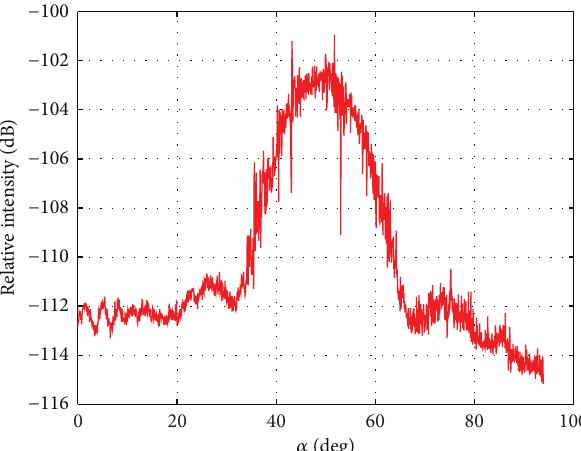
Figure 4: Strip chart of Cassiopeia A passing through the antenna array pattern due to the Earth’s rotation at 57.105 MHz. The angle 𝑡 is proportional to the travel time 𝑡 of Cassiopeia A, and the 𝛼 = V 𝛿 source velocity on the celestial sphere for the declination 𝛿 is defined as V 𝛿 = 15( 󸀠󸀠 / sec ) cos 𝛿 in angular seconds per (time)